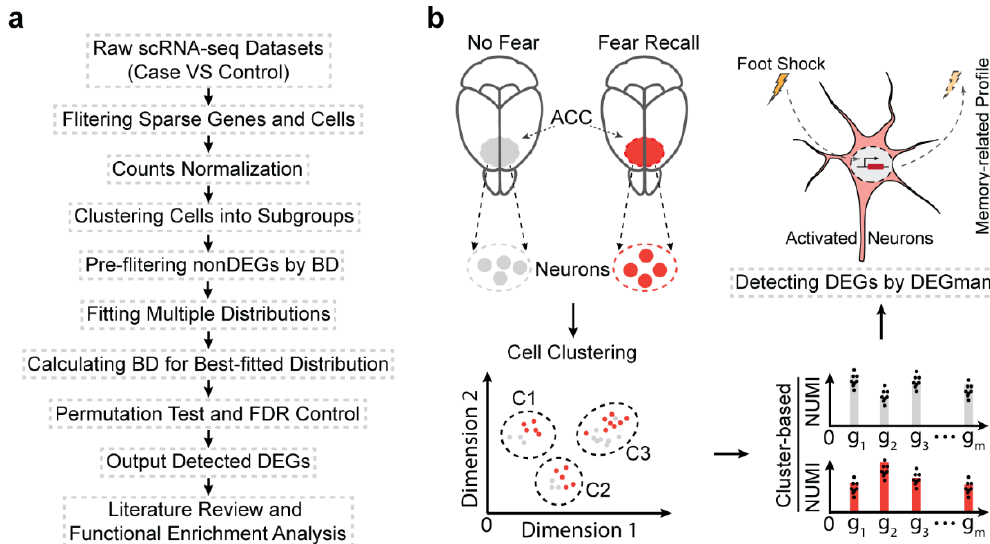
Figure 1. Overflows of DEGman method and detecting fear-memory-related genes. ( a ) Workflow of DEGman method. ( b ) The application of DEGman to detect memory-related genes from mouse neurons with fear memory. BD: Bhattacharyya distance NUMI: normalized UMI. ACC: anterior cingulate cortex.